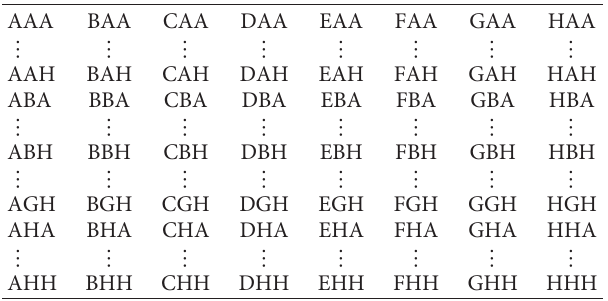
∘ C . 3 4 Table 3: Minimum outer-convex dominating sets of G , where n �